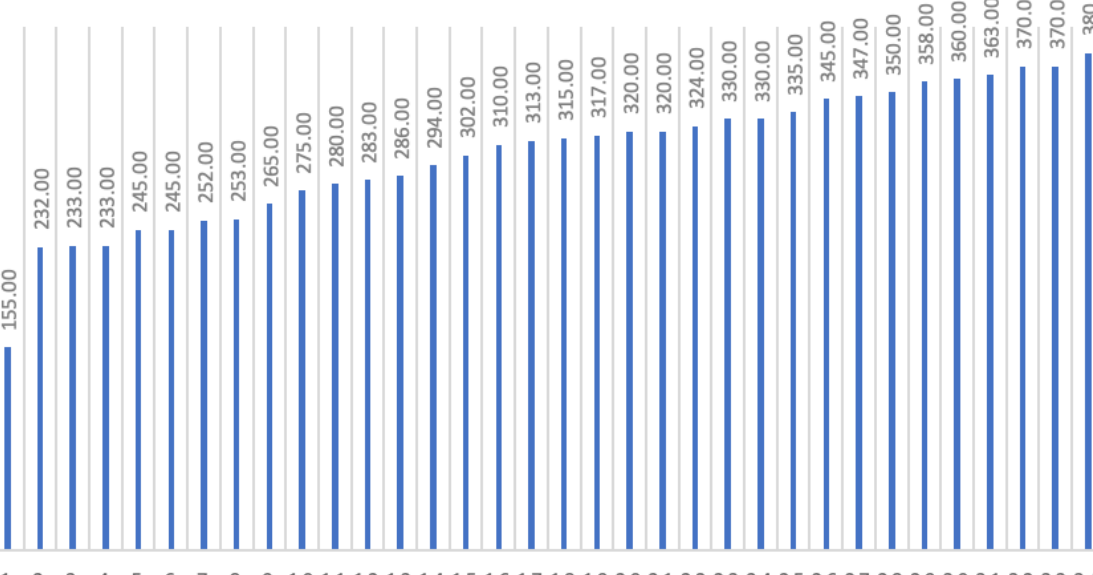
Figure 6. The height of the studied miniature columns from Gonur Depe (all together with one fragment of a miniature column (Figure